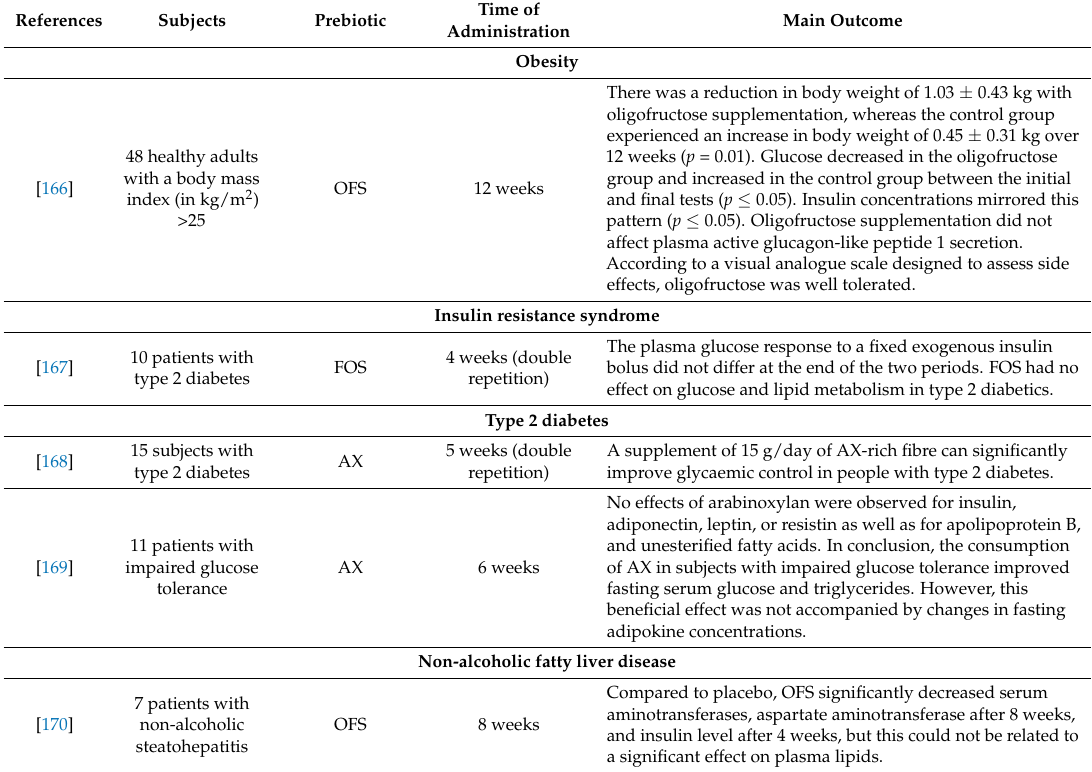
Table 5. Examples of clinical trials regarding the effect of prebiotics on human